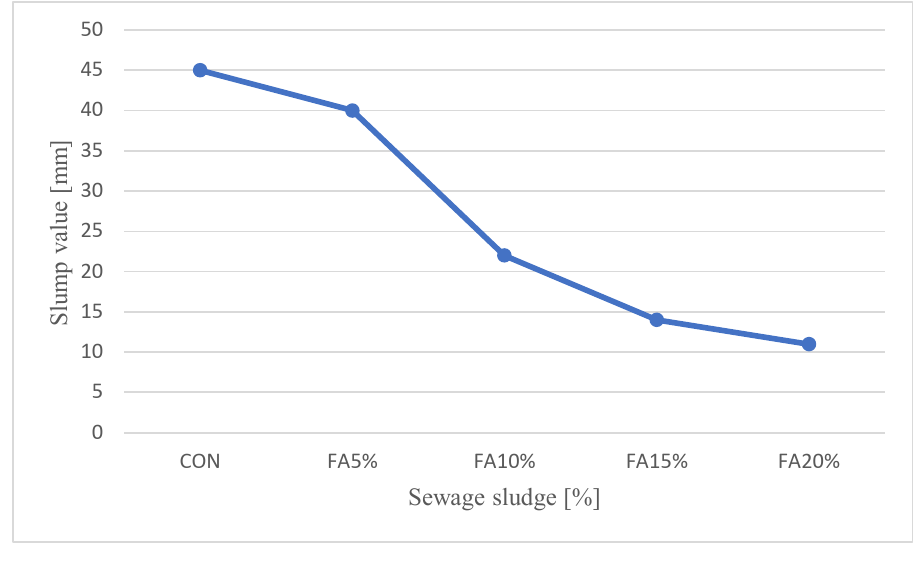
Figure 7. Concrete mix consistency.